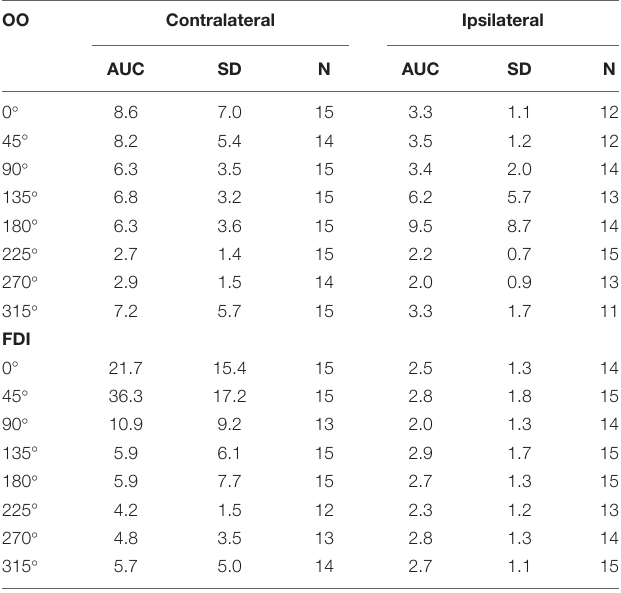
TABLE 1 | Average Area Under the Curve (AUC) in mV · ms, plus standard deviations (SD), and number of subjects (N) contributing to the average, for Orbicularis Oris (OO) and First Dorsal Interosseous (FDI) muscles per coil orientation. OO